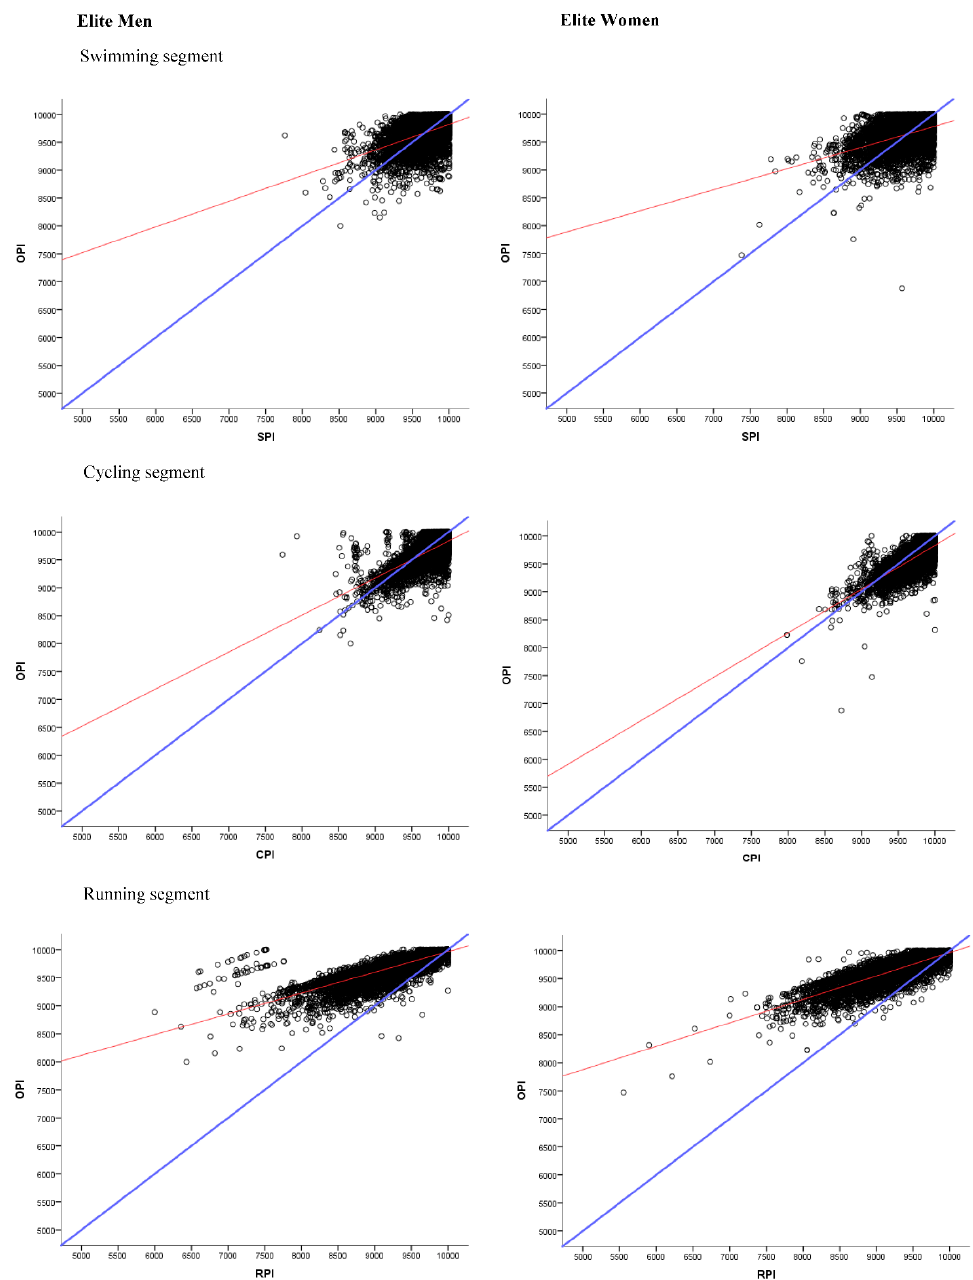
Figure 1. Distribution of the overall performance indicator (OPI) concerning the swimming perfor- mance indicator (SPI), cycling performance indicator (CPI), and running performance indicator (RPI).